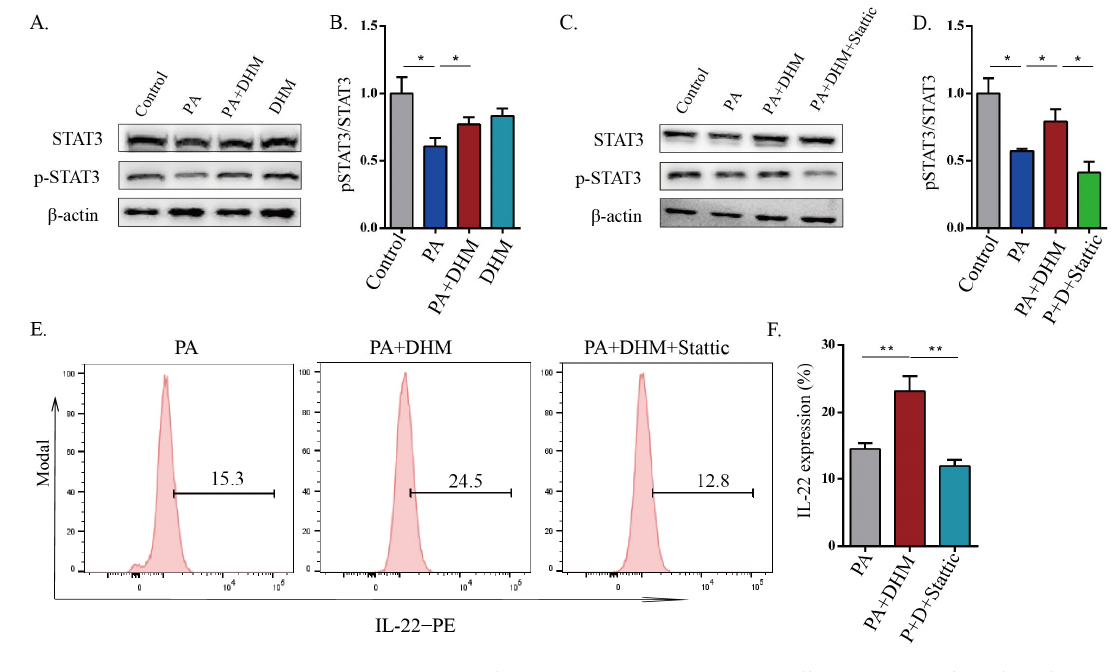
Figure 4. DHM promoted IL ‐ 22 expression in MNK3 cells via STAT3 phosphorylation. ( A , B ) Representative immunoblots of STAT3 and p ‐ STAT3 in the indicated groups, and quantitative graphs show the ratios of p ‐ STAT3/STAT3. ( C , D ) The protein expressions of STAT3 and p ‐ STAT3 after pretreatment with STAT3 inhibitor Static. ( E , F ) IL ‐ 22 expression in the indicated groups was detected with flow cytometry. * p < 0.05, ** p < 0.01, as determined by one ‐ way ANOVA followed by the Tukey–Kramer post hoc test.